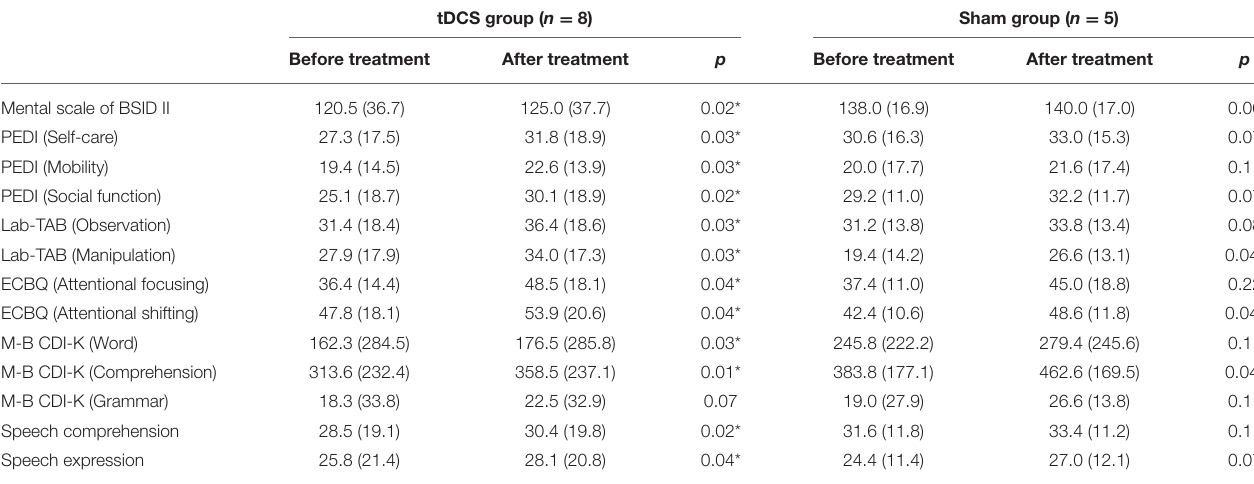
TABLE 2 | Comparisons of outcomes before and after treatment in each group.